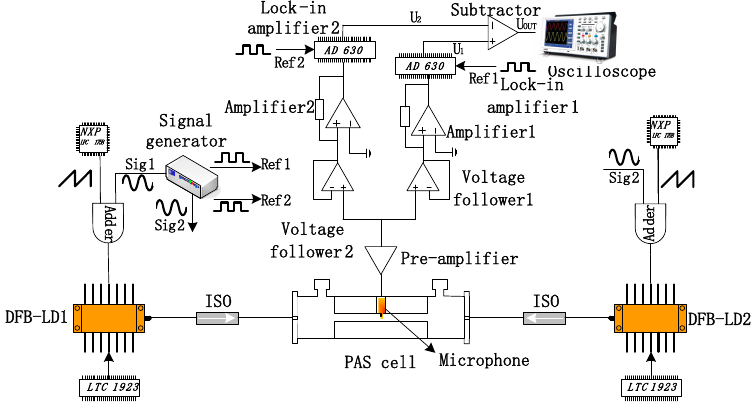
Figure 1. Schematic of the dual path lock-in system.